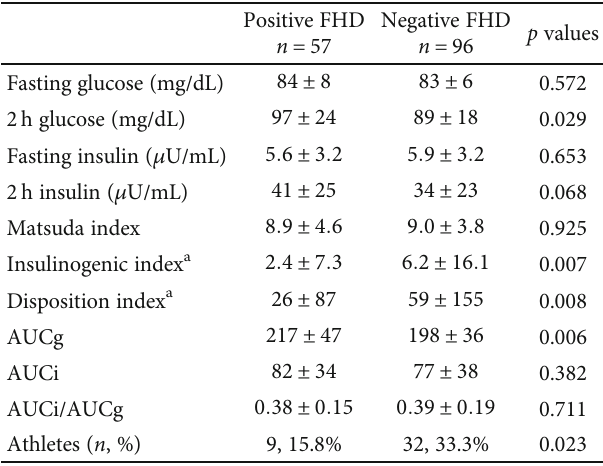
Table 2: Glucose and insulin responses during 75g oral glucose tolerance tests of young women in the presence and absence of family history of type 2 diabetes